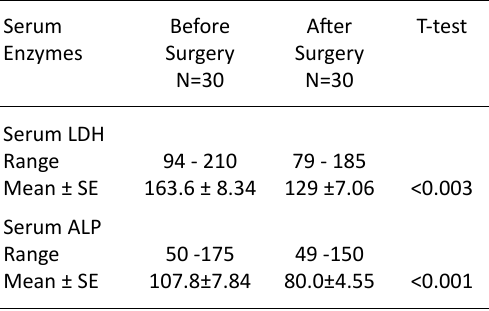
table 3. The difference in mean levels of serum enzymes (U/L) concentration between preoperative group and postoperative group of patients Serum Before After T-test Enzymes Surgery Surgery